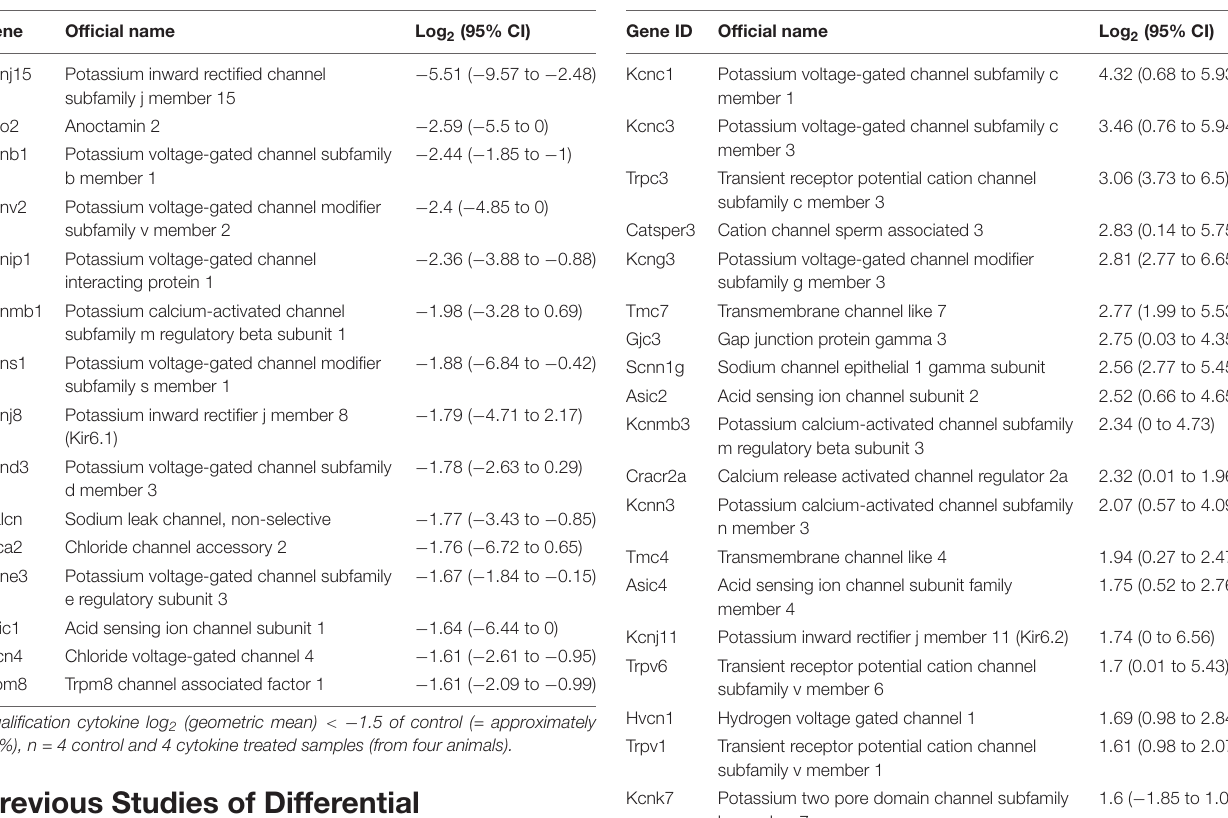
TABLE 2 | FLS channel gene RNA expression increased after cytokine (10 ng/ml TNF α and IL1 β )